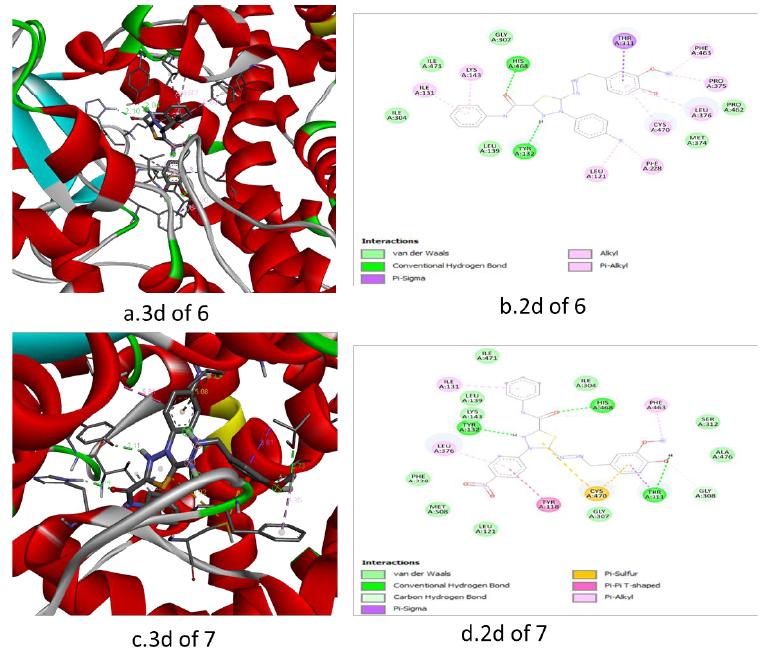
Figure 13. Interaction of the docked compounds 6 and 7 with fungal sterol 14 α -demethylase (CYP51).